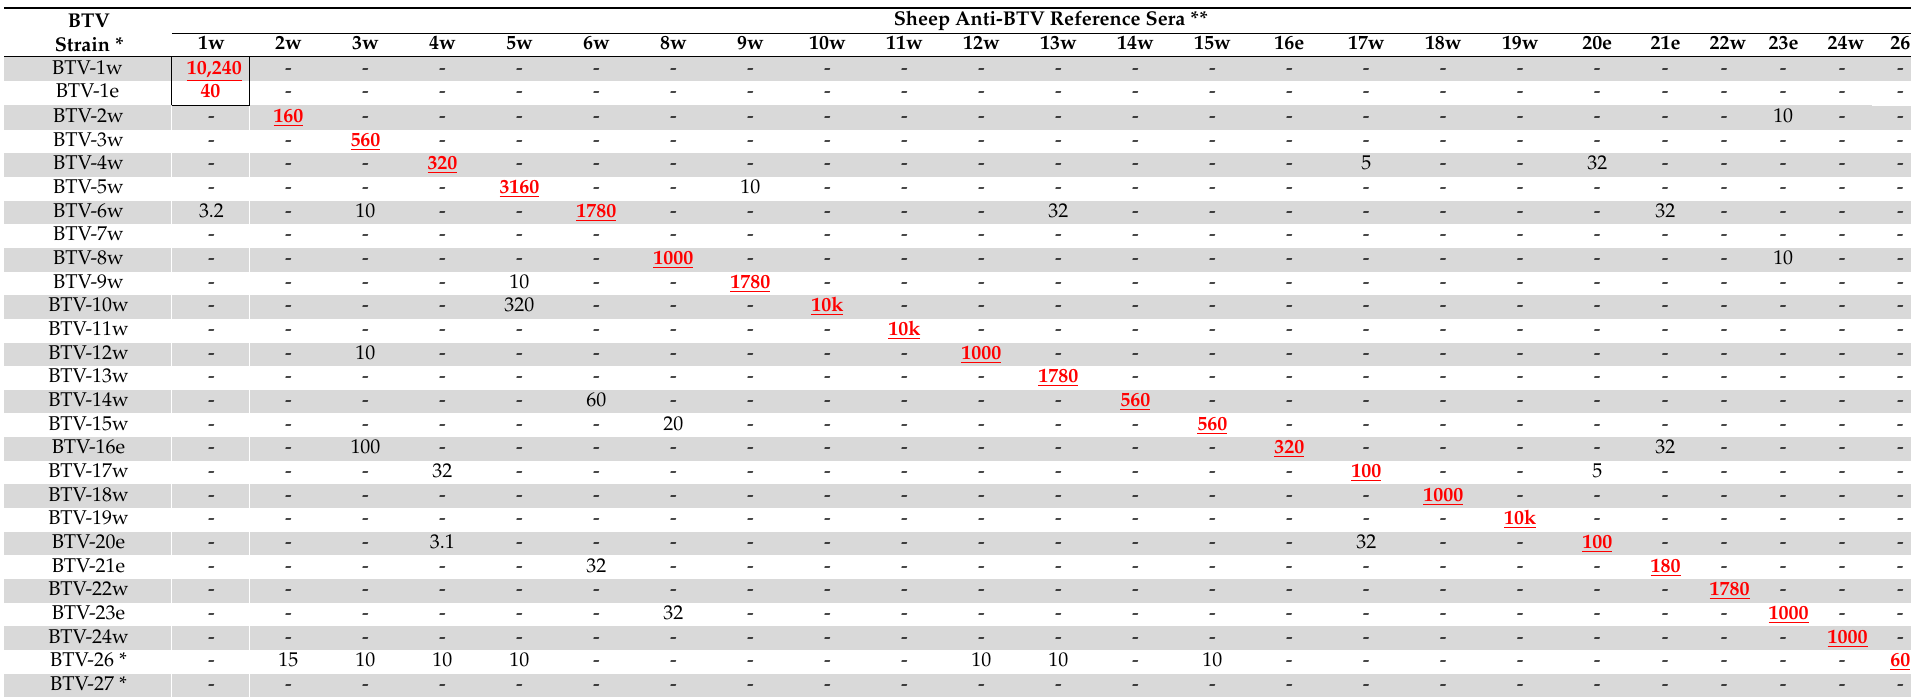
Table 5. nAb titres of sheep BTV reference-antisera in SNT using reference strains of BTV-1 to -24, -26 and -27. BTV Strain